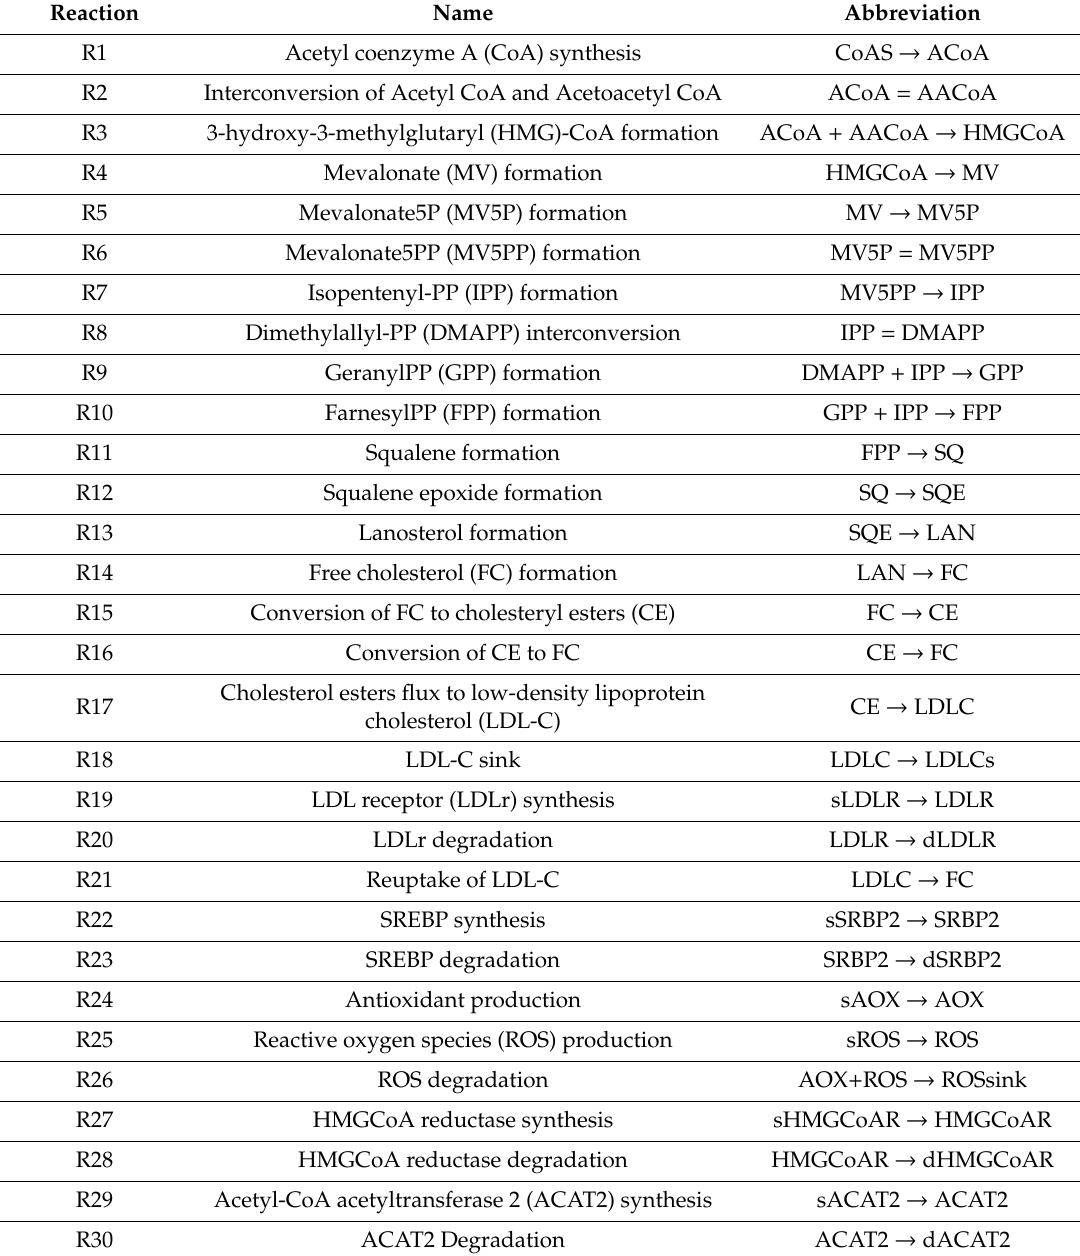
Table 1. List of Model Reactions